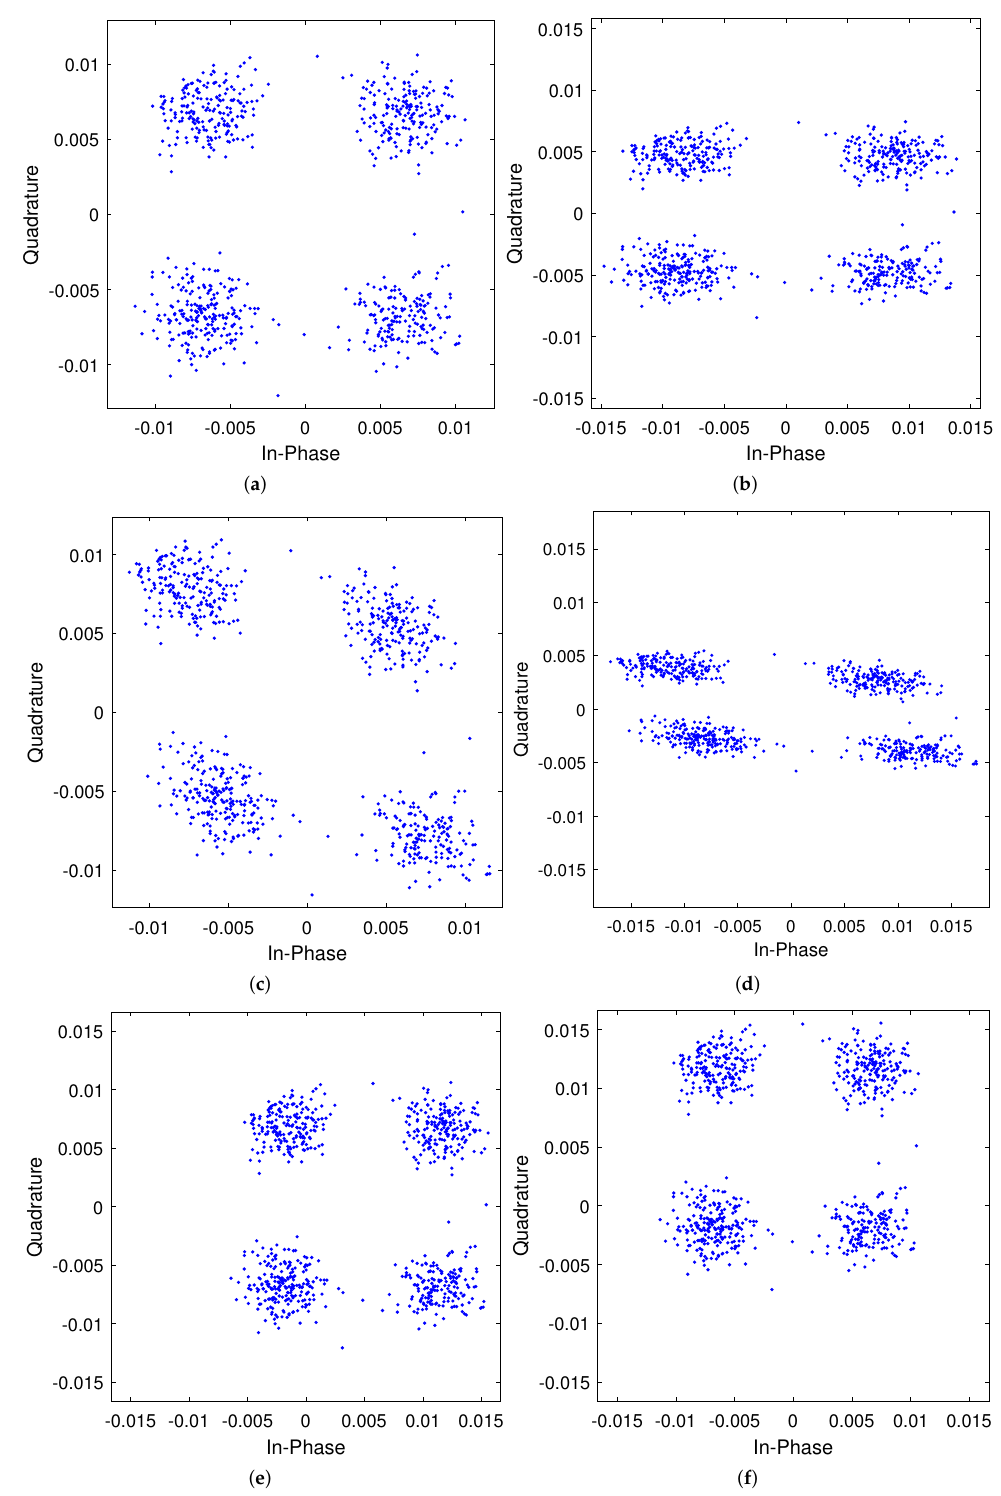
Figure 10. Constellation diagram shows the effect of the different I/Q and DC offset on the M = 32, N = 32 OTFS received information symbols of ˆ y [ k , l ] for 4-QAM at 2.4 GHz carrier frequency. ( a ) (cid:101) = 0, ∆ φ = 0; ( b ) (cid:101) = 0, ∆ φ = 10; ( c ) (cid:101) = 0.5, ∆ φ = 0; ( d ) (cid:101) = 0.5, ∆ φ = 10; ( e ) γ I = 0.75, γ Q = 0; ( f ) γ I = 0, γ Q =